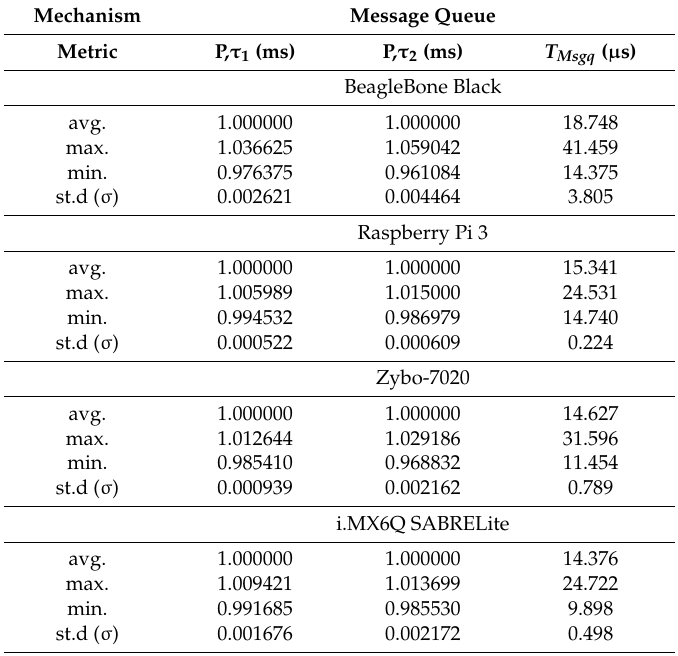
Table 5. Statistical results of the message queue mechanism and the periodicity of two tasks.